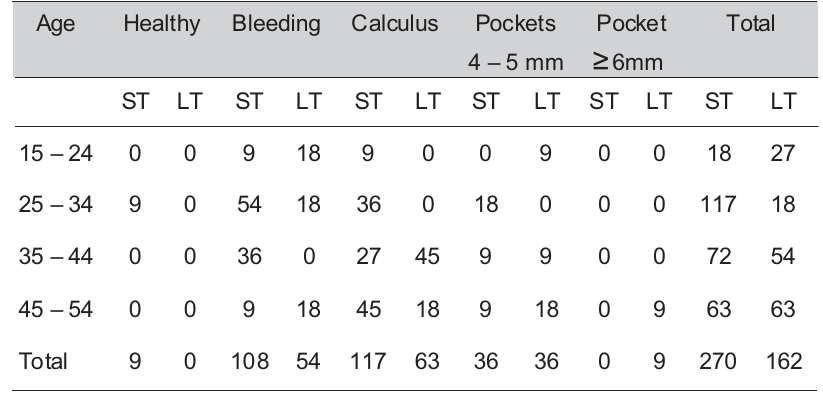
Table 4 - Distribution of short time (ST – 1 to 10 years) and long time (LT – greater than 10 years) tobacco users in accordance with CPI scores in different age groups